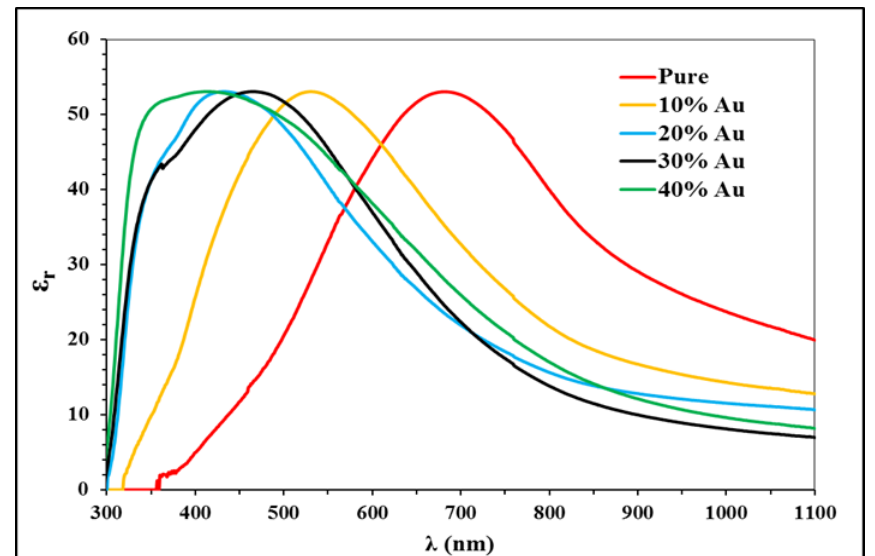
Fig. 17: The real part of dielectric constant for pure WO and 40)% thin films as a function of wavelength at T